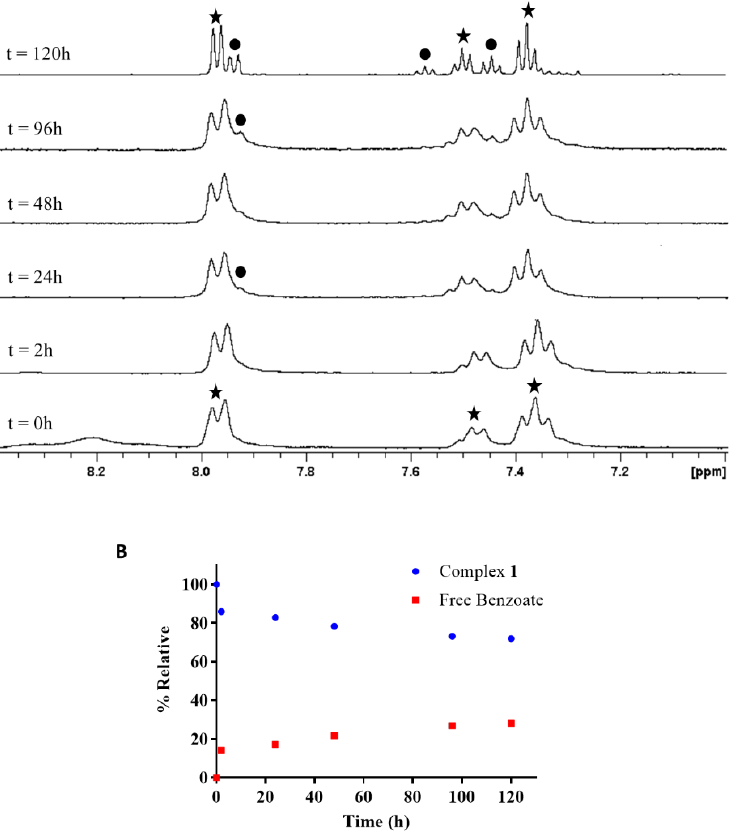
Figure 8. ( A ) Portion of the 1 H-NMR spectra (300 MHz) of compound 1 treated with an excess of glutathione (1:6 molar ratio) in Acetone-d 6 /D 2 O (550:100, v / v ) at 37 °C, taken at different time intervals. The spectrum at 120 h was recorded on a 500 MHz instrument. The stars indicate the peaks of starting complex 1 , while the black dots indicate the peaks of free benzoate. ( B ) Relative percentages of 1 and free benzoate, obtained by integration of 1 H NMR deconvoluted signals (8.10 – 7.80 ppm), plotted as a function of time.